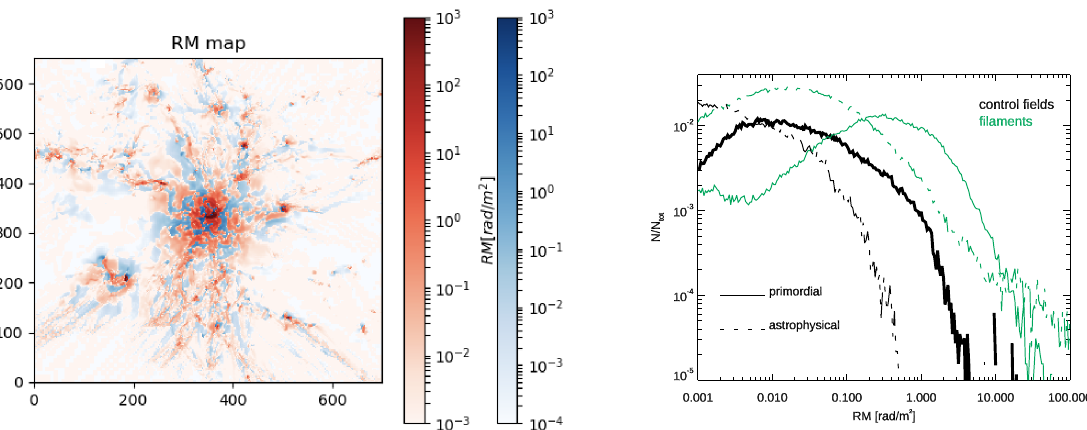
Figure 6. ( Left ) RM distribution for our e18b cluster at z = 0, simulated with the cooling and feedback model, in which magnetic fields are injected by AGN activity. The box as the meaning of colors is as in Figure 1. ( Right ) distribution of RMs for all filament and control fields, for the primordial and the astrophysical model.